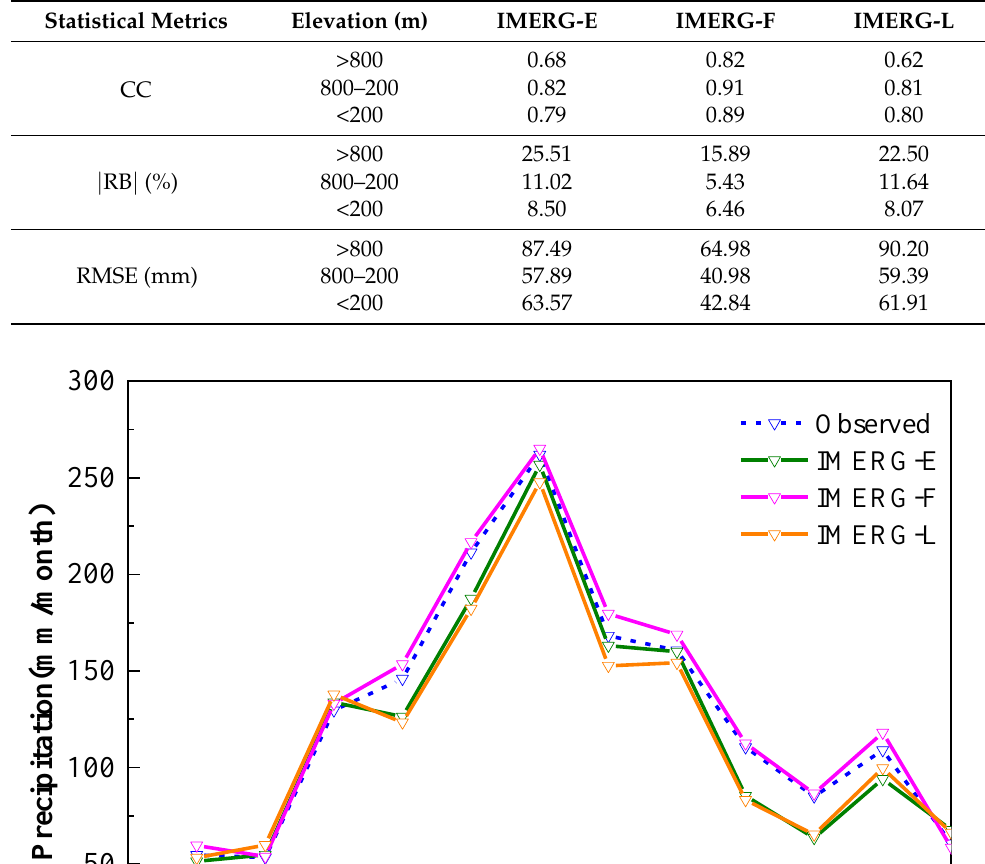
Table 3. Comparison of monthly precipitation between IPPs and observed precipitation values and a calculation of the average of three statistical indicators related to elevation from 2015 to 2020.